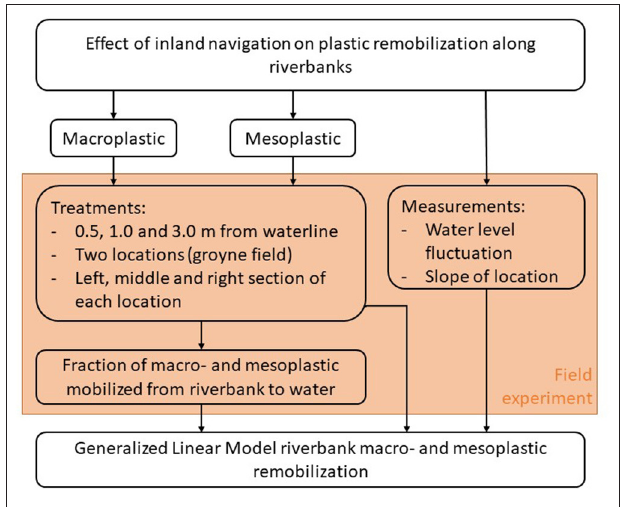
FIGURE 1 | Flow chart of the used experimental set-up to assess macro- and mesoplastic remobilization under the influence of inland navigation induced waves and the resulting model on